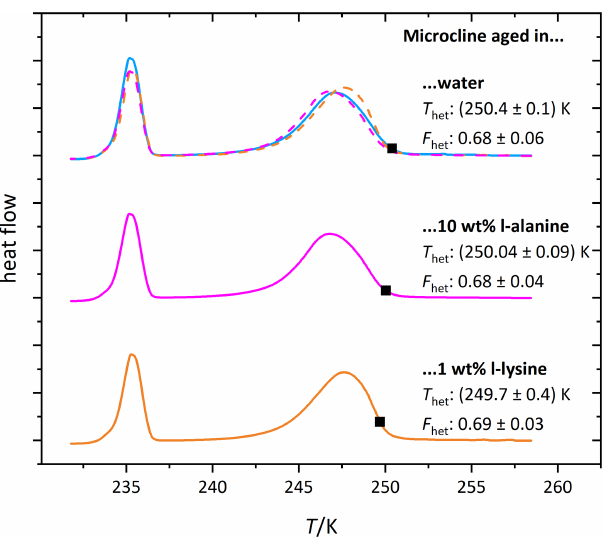
Figure 10. DSC thermograms of microcline (2wt%) after 10d of aging in the respective solutions ( l -alanine: 10wt%, a w ≈ 0 . 977; l -lysine: 1 wt%, a w ≈ 0 . 994) and subsequent washing. The ther- mograms are normalized with respect to their total integral. The av- erage freezing onset temperatures are marked by black squares. For easier comparison the thermograms of the solutions are overlaid as dashed lines above the thermogram of the pure water case. The dis- played T het and F het values are the average of two measurements. The corresponding uncertainties are the standard